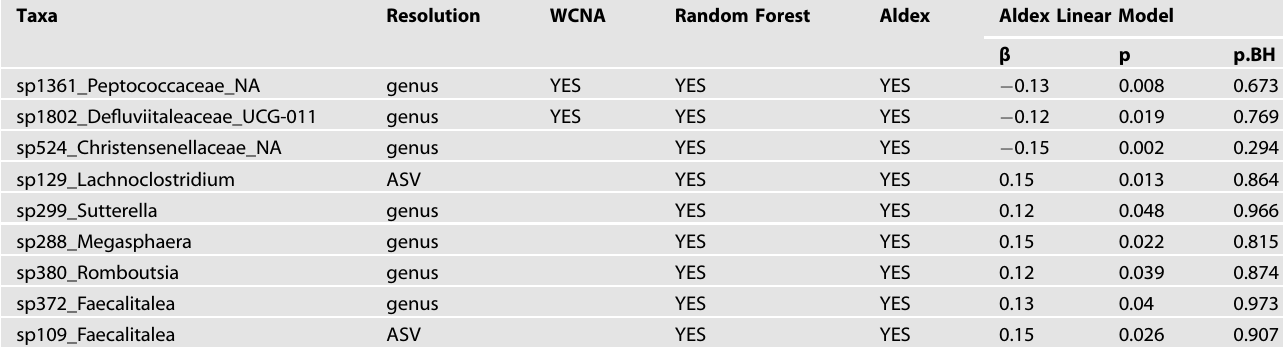
Table 3. Consensus mood-associated taxa (PHQ-9